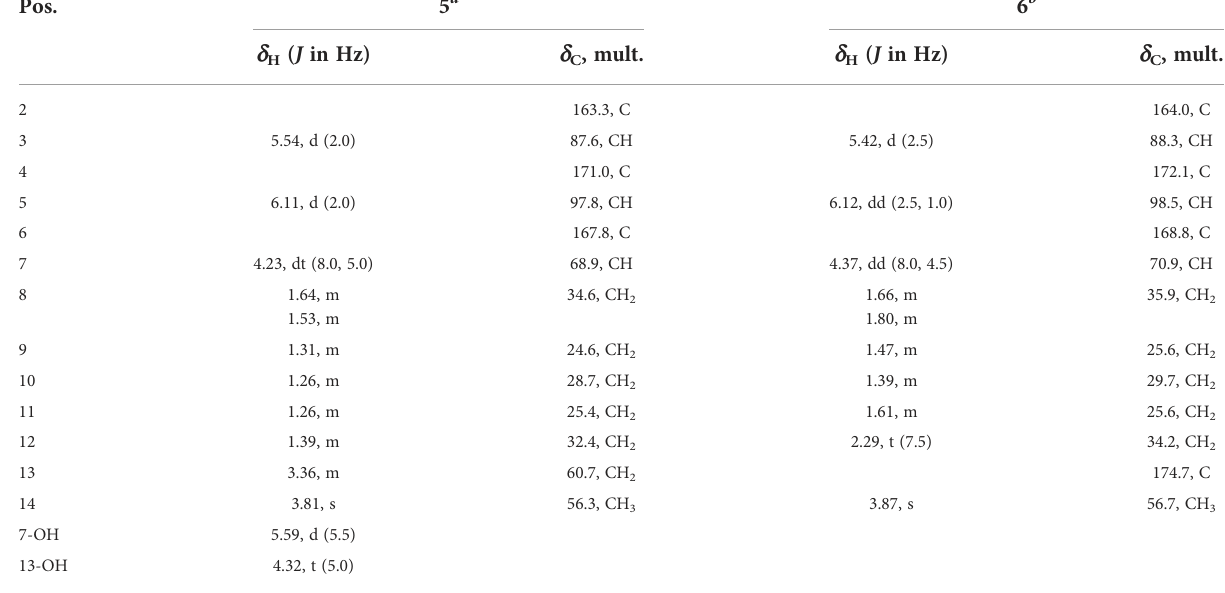
TABLE 2 NMR data for compounds 5 and 6 ( d in ppm, J in Hz). Pos.